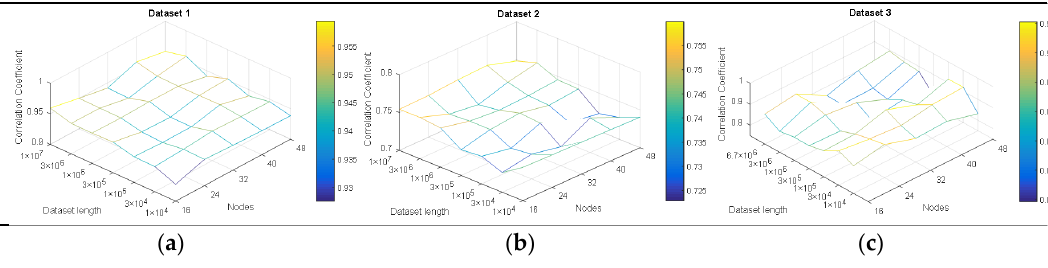
Figure 9. Correlation coefficient on former three datasets. ( a ) Dataset 1; ( b ) Dataset 2; ( c ) Dataset 3.